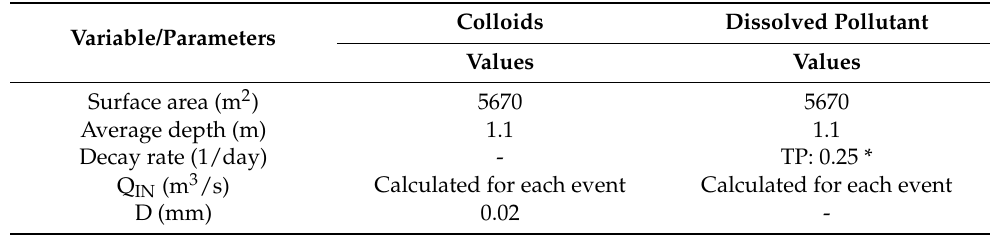
Table 3. List of design variables and parameter values used in the water quality module by pollutant type.